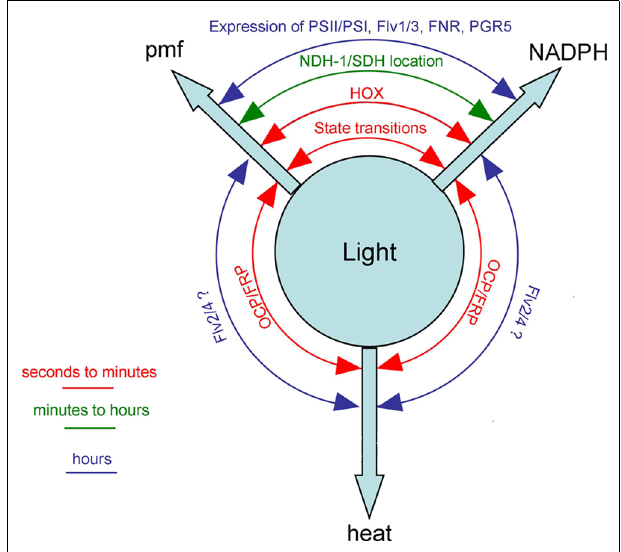
FIGURE 2 | Cyanobacterial mechanisms for switching between the three principal outputs of photosynthesis [proton-motive force (pmf), reducing power (NADPH) and heat] with the approximate timescales on which they occur. See text for discussion and references. FRP, fluorescence recovery protein; NDH-1, complex I/NAD(P)H dehydrogenase; SDH, complex II/succinate dehydrogenase. Other abbreviations defined in the legend to Figure 1